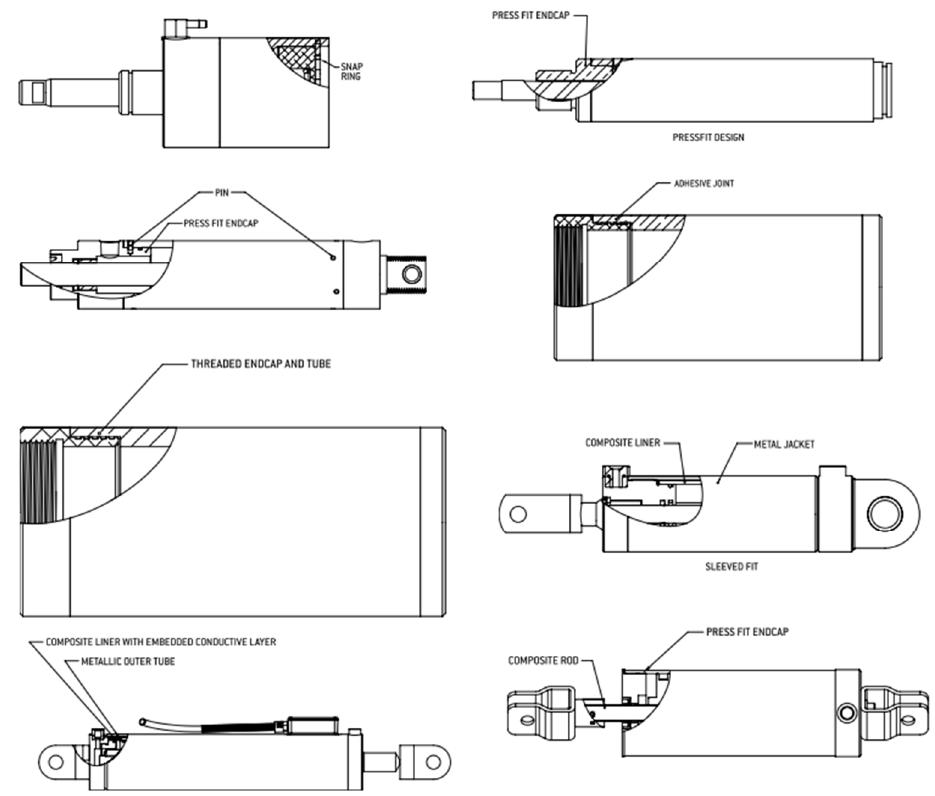
Figure 16. Various designs offered by Polygon [56].